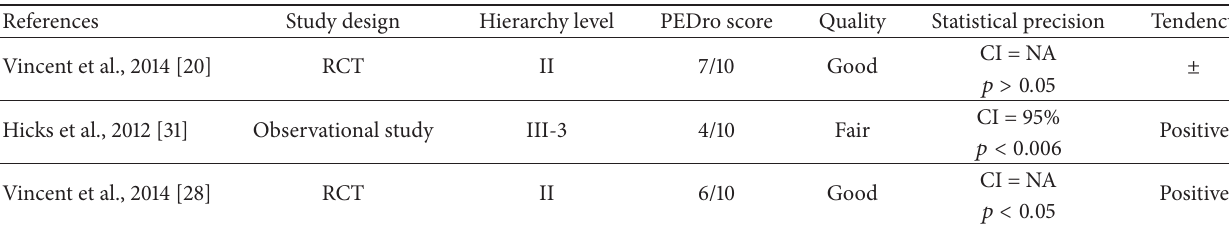
Table 3: Trends in evidence.